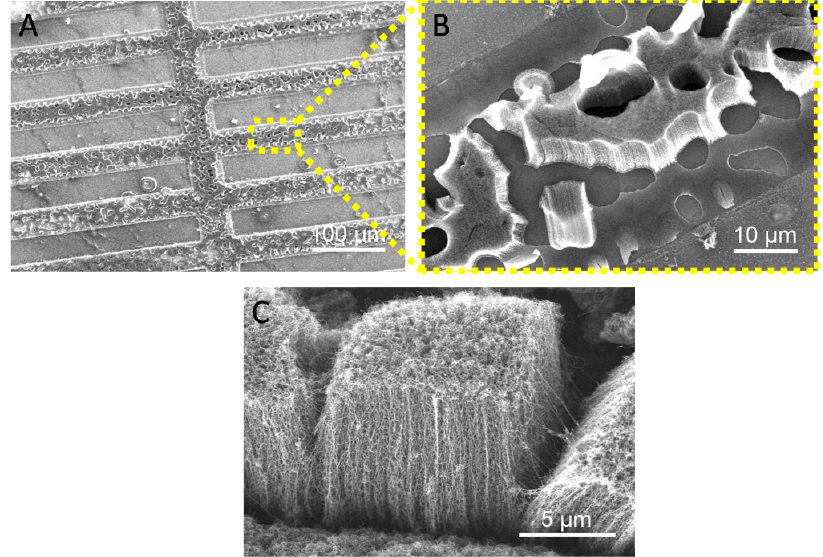
Figure 6. SEM image of the patterned sample after the AC-CVD synthesis ( A ). Zoom-in corresponding to the TiN lanes where VA-SWNTs are grown ( B , C ).